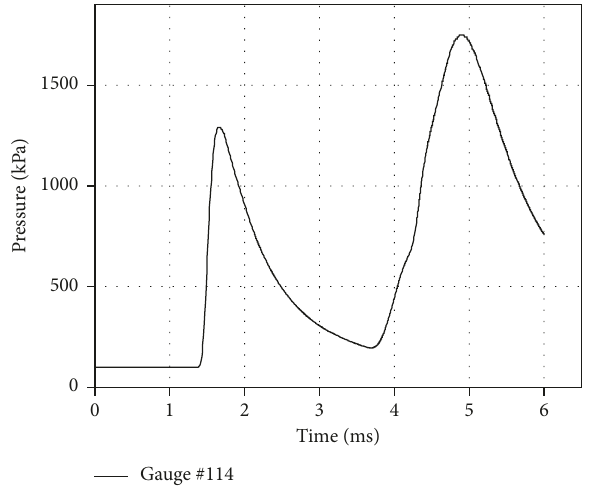
Figure 19: Velocity-time history of Gauge